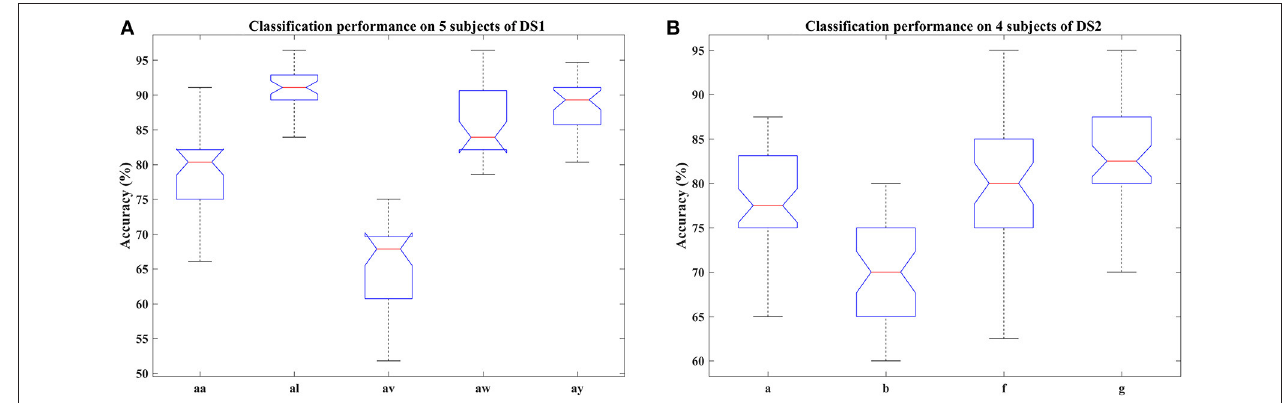
FIGURE 3 | Classification performance of COL on nine subjects: (A) aa, al, av, aw, and ay of DS1, (B) a, b, f, and g of DS2. Blue box indicates the range from 25 and 75% of the accuracy distribution, red line marks the median of the accuracy, notches in the box indicate the variability of the median between samples at the 5% significance level, extended whisker is the furthest observations in the range of 1.5 times the interquartile range away from the top or bottom of the box.